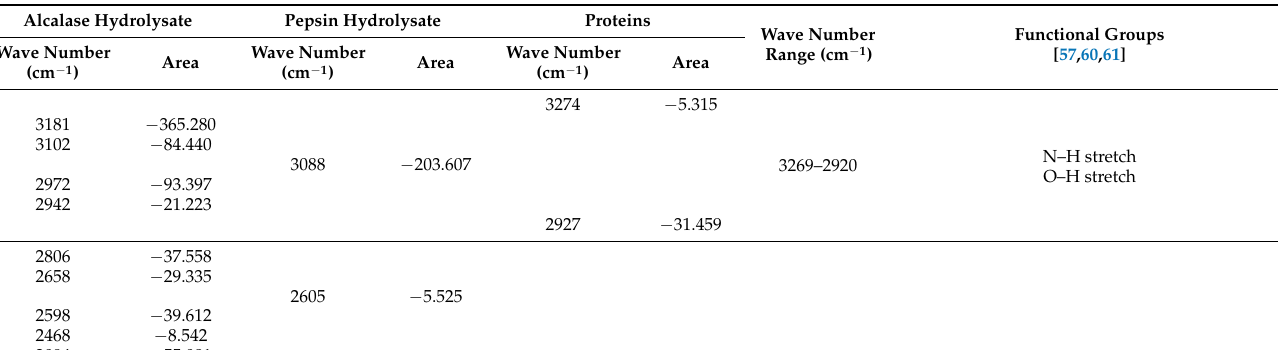
Table 2. Summary of wave numbers and corresponding functional groups.